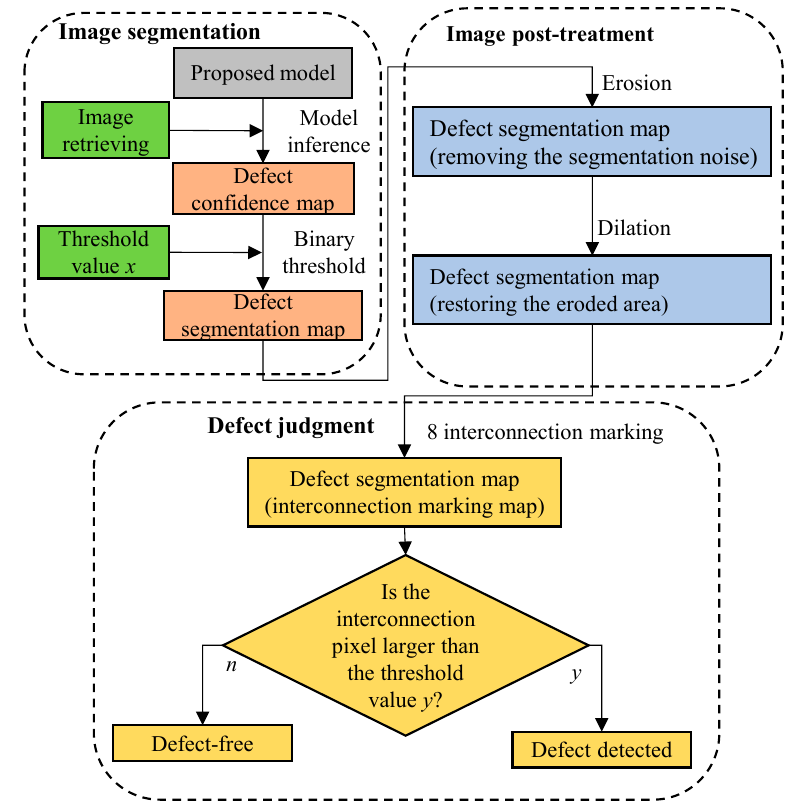
Figure 10. Post-treatment flow chart.